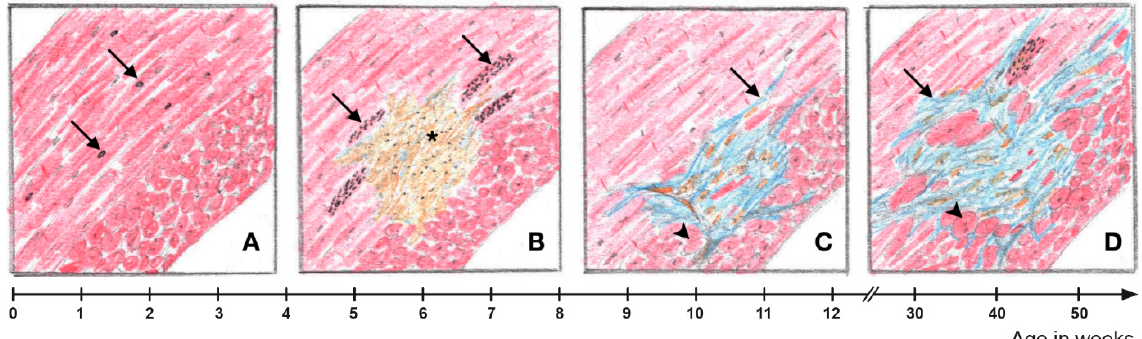
Figure 9. A spatial relationship exists between myocardial fibrosis and cardiomyocytes with increased autophagic activity in Dsg2 -mutant hearts. ( A ) Prior to structural disease onset, some Dsg2 -mutant cardiomyocytes in the circular myocardium, which experience high mechanical stress, show signs of increased autophagic activity as evidenced by isolated autophagic vacuoles (arrows). ( B ) Focal cardiomyocyte necrosis occurs at the onset of the acute phase of AC progression (*). Cardiomyocytes with markedly increased activity of autophagy and ER stress can be found in the vicinity of cell- rich lesions (arrows). ( C ) Connective tissue remodeling of the myocardial lesions is completed at the end of the acute phase. In the area of mature replacement fibrosis, incipient hypertrophy of adjacent cardiomyocytes can be detected (arrowhead). In addition, interstitial fibrosis becomes apparent (arrow). ( D ) Interstitial fibrosis expands during the chronic AC phase. There is also distinct hypertrophy of cardiomyocytes in the vicinity of fibrotic myocardial lesions. Signs of ER stress and increased autophagic activity are again detectable in perilesional